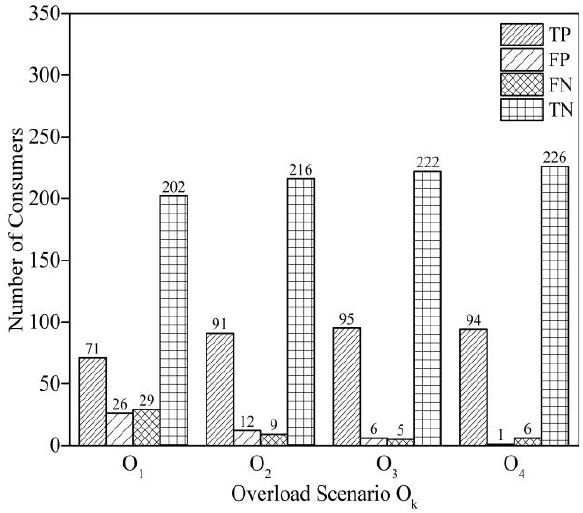
Figure 6. Confusion matrix for overload power theft scenarios (O k ).